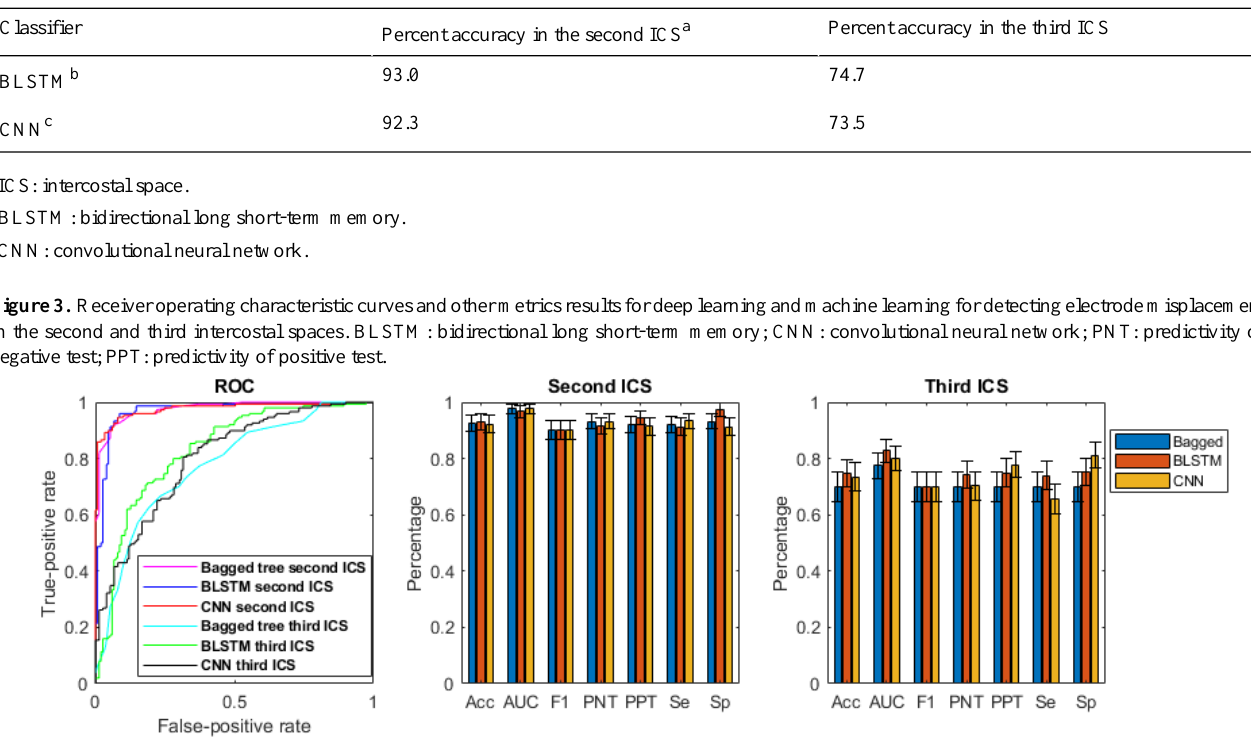
Table 3. Classification accuracy using two deep learning networks.